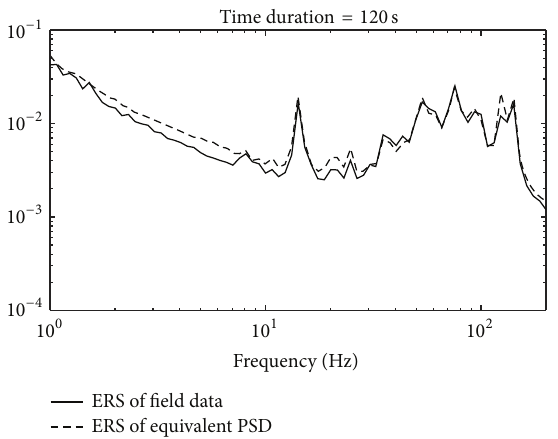
Figure 17: The ERS of the field data and the equivalent PSD ( 𝑇 = 120 s).